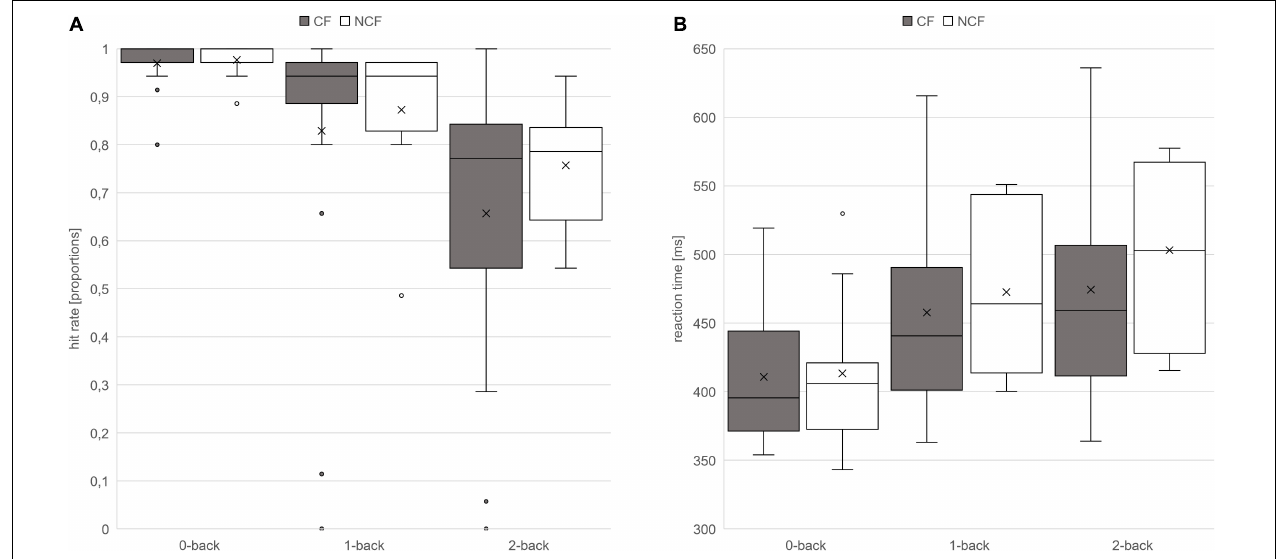
FIGURE 3 | Hit rates and response times in n-back task. Hit rates (in proportions) (A) and response times (in milliseconds) (B) on the n-back task in sarcoidosis patients with versus without chronic fatigue presented as box–whisker plots. Horizontal lines denote (from bottom to top) minimum, third quartile, median, first quartile, and maximum. Crosses indicate arithmetic means; points denote statistical